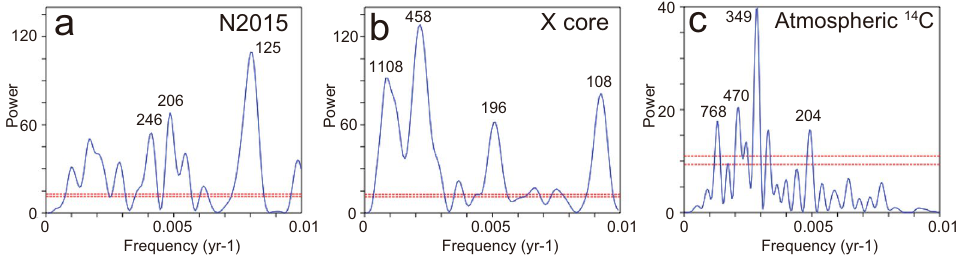
Figure 4. Spectral analysis of standardized values. ( a ) δ 18 O records in ostracode shells from the N2015 core. ( b ) δ 18 O records in ostracode shells from the X core 19 . ( c ) Atmospheric 14 C 23 . Numbers show the periodicities for the main spectral peaks. The 0.01 and 0.05 significance levels are shown as dashed red lines.